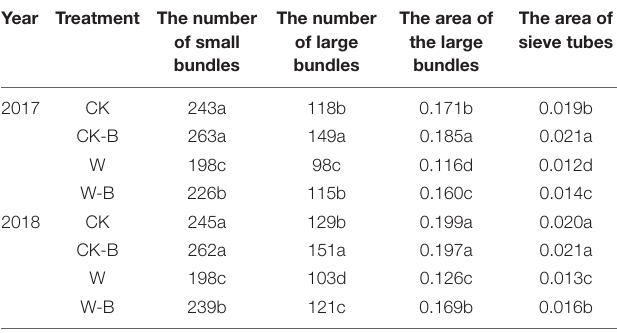
Different letters on bars indicate the significant differences among treatments at P < 0.05 using the LSD